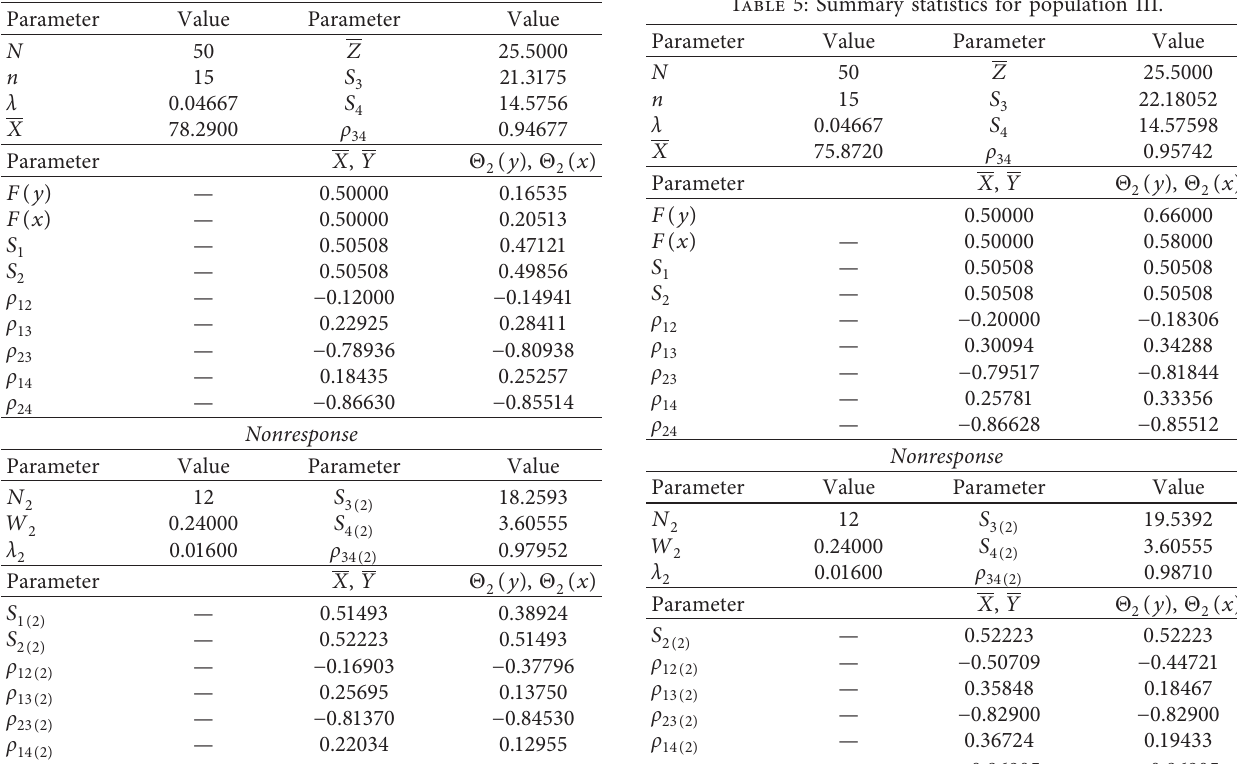
Table 4: Summary statistics for population II.